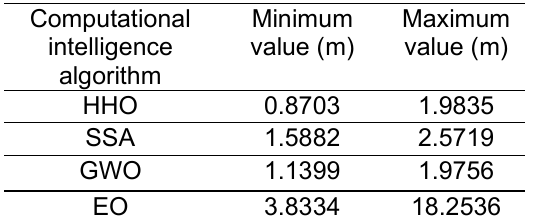
Table 2. Minimum and maximum mean localization error of computation intelligence algorithms